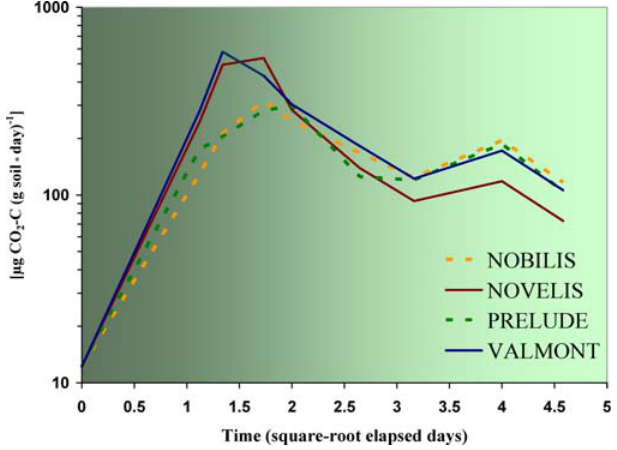
Figure 2. Amount of CO 2 -C after Addition of Maize Residues Temporal variance in gross soil respiration of a stagnic luvisol after the addition of maize straw. Dotted lines for crop residues from conventional maize, continuous lines for transgenic maize. Untreated soils without any addition of straw showed initial respiration values of 12 l g CO 2 -C at d 0 ( n ¼ 5). MON810 (Novelis) and Event 176 (Valmont) are transgenic. The differences between these cultivars and their mother plants were significant: conventional straw did not enhance soil respiration as much as transgenic straw (ANOVA: p , 0.00001). DOI: